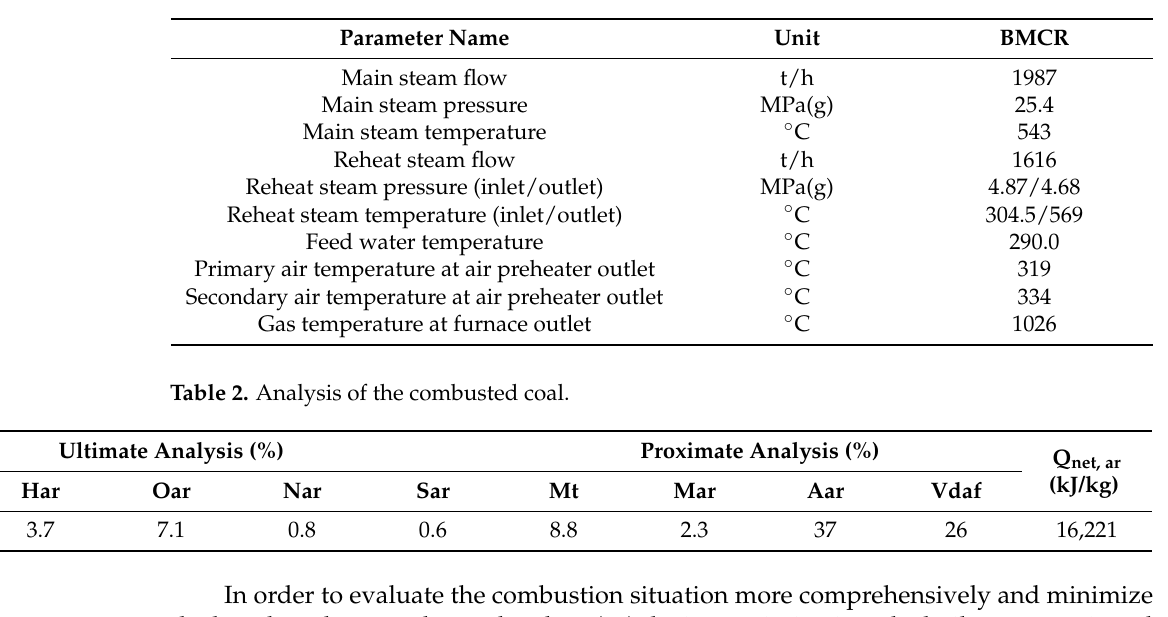
Table 1. Main design parameters of the boiler.